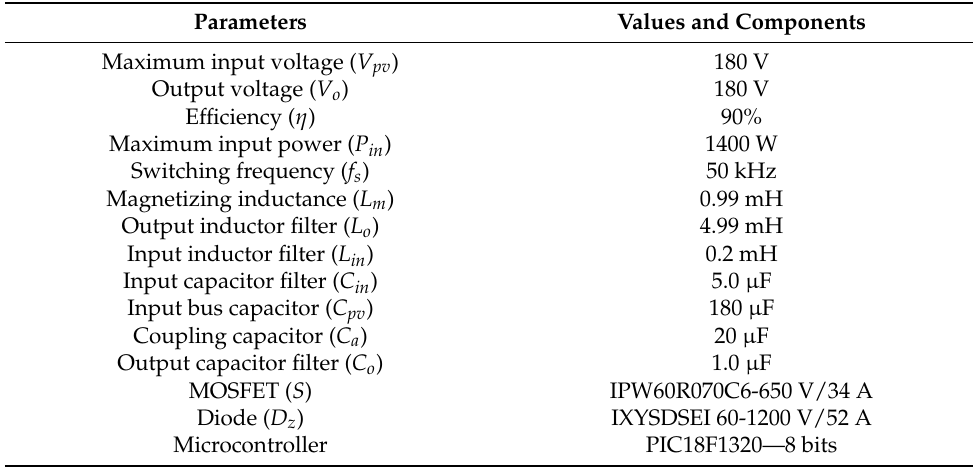
Table 4. Zeta Converters Parameters.